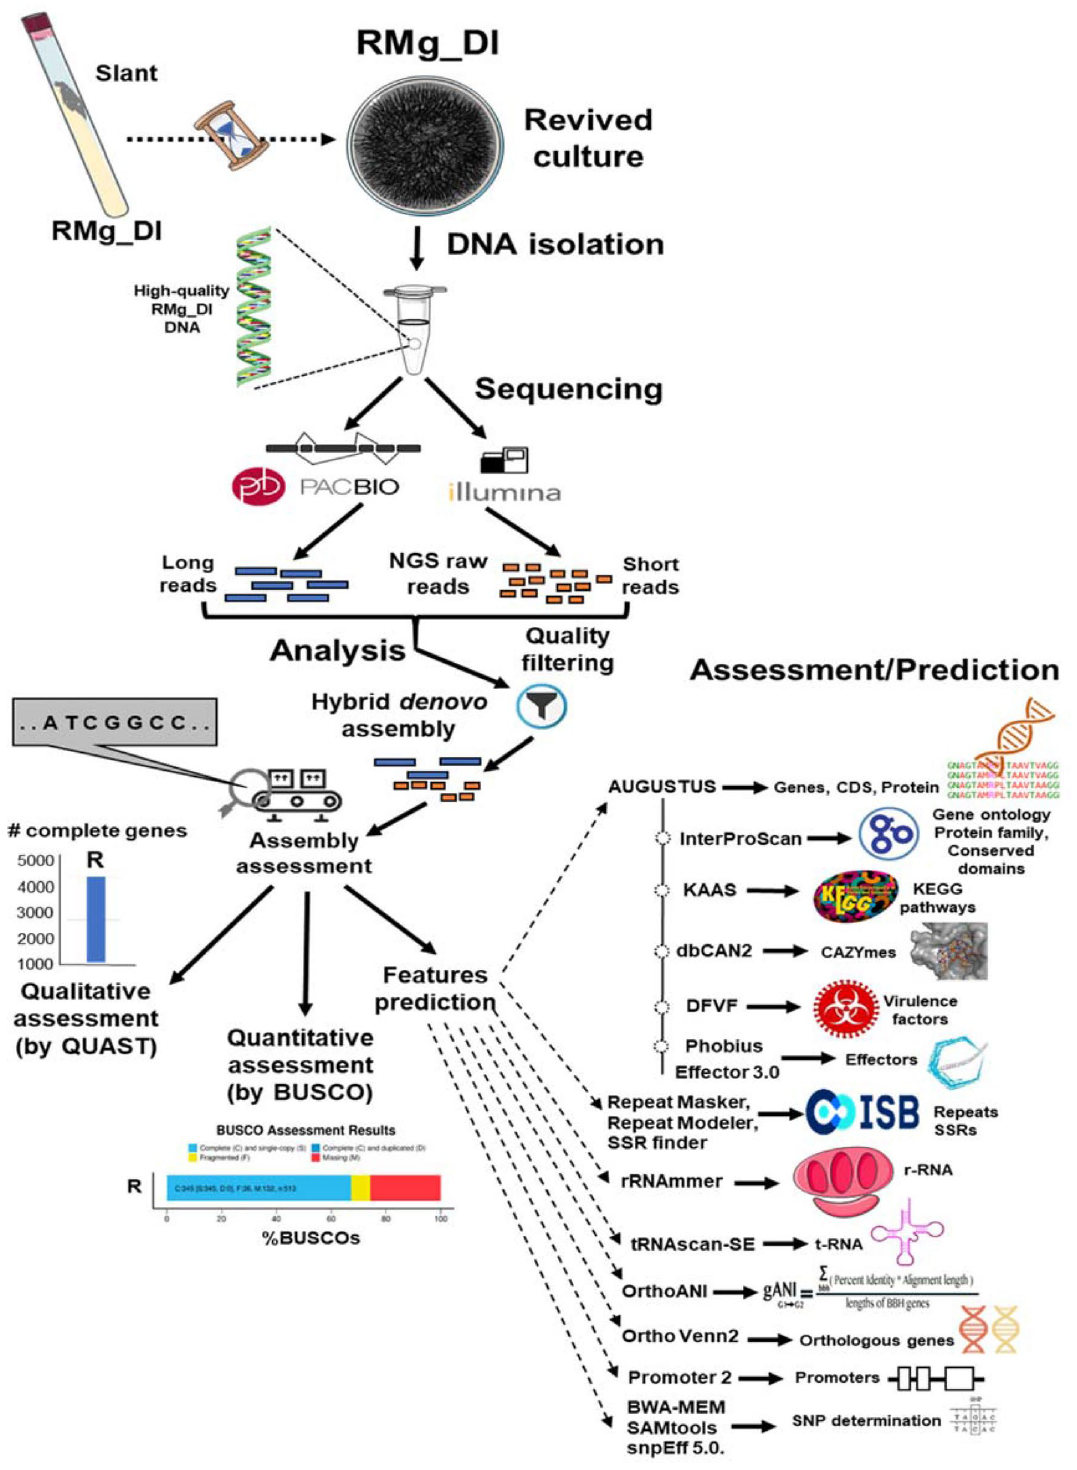
Figure 1. Schematic illustration of the WGS analysis of M. oryzae